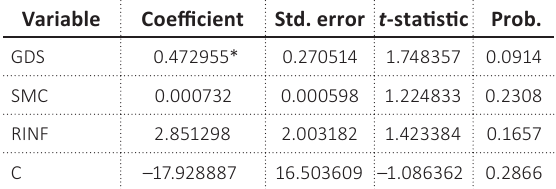
Table 6. Long-run model for liquid liabilities and finance for growth